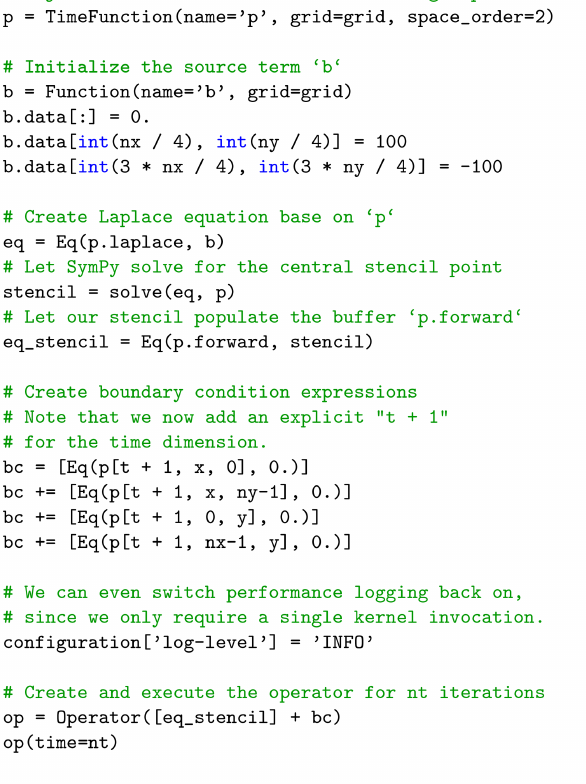
Figure 19. Poisson equation in Devito with buffered dimension for automatic swap at each